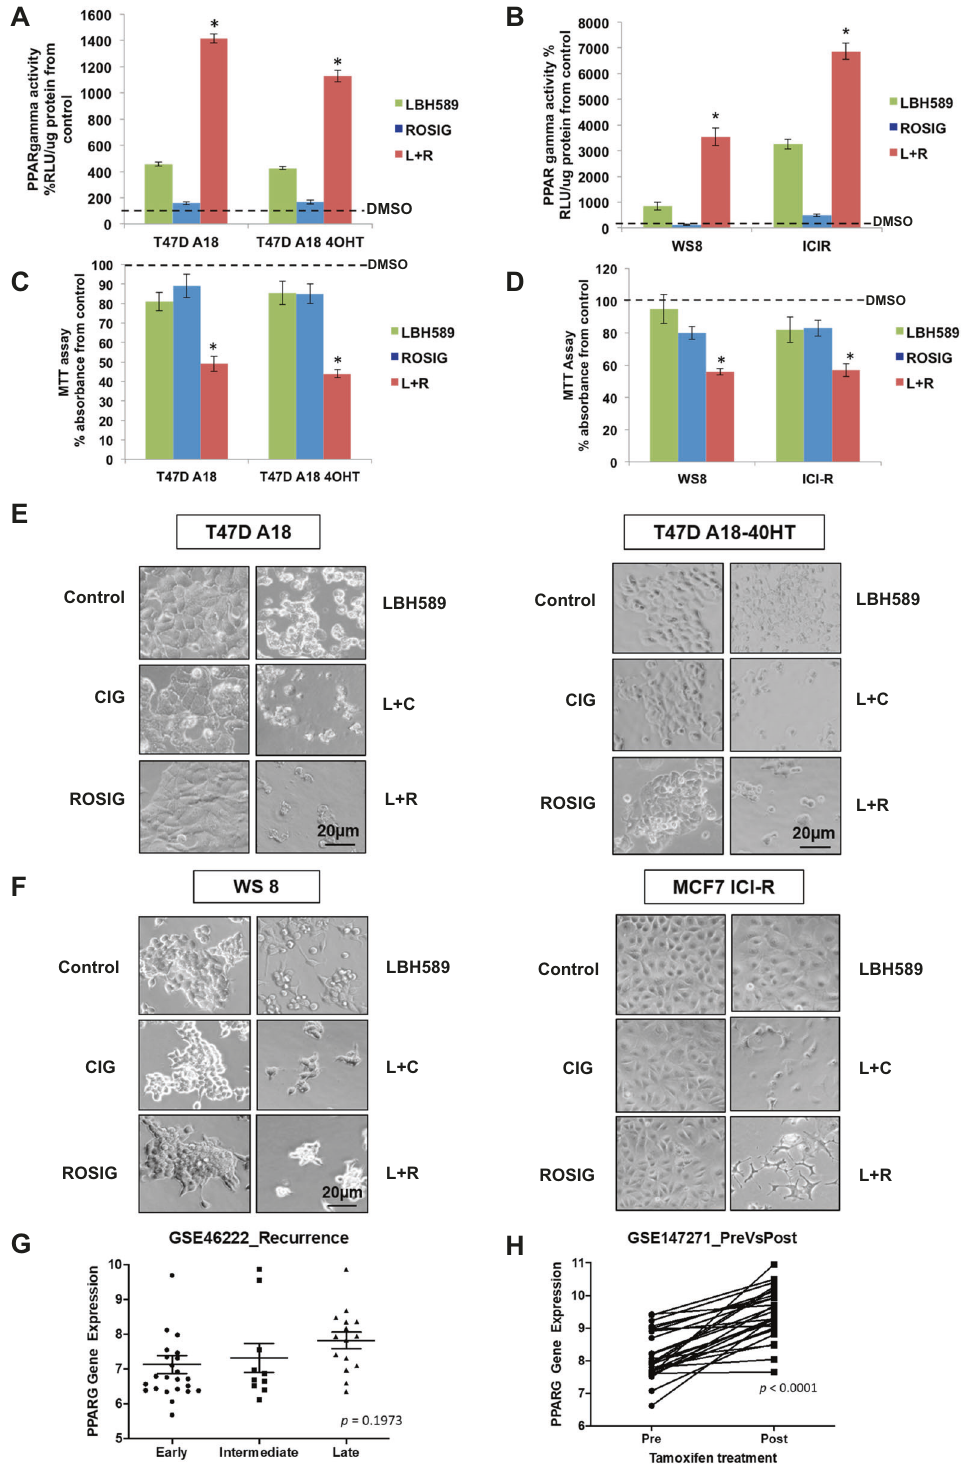
RNA isolation, reverse transcription (RT), and real-time polymerase chain reaction (RT-PCR) Total RNA was isolated from cells using TRIZOL reagent (Invitrogen, Carlsbad, CA, USA), as described in the manufacturer ’ s instructions with a DNAse treatment step incorporated into the protocol. Each RT reaction contained 2.5 µg of total RNA, 1× RT buffer, 5 mM MgCl 2 , 425 µM each